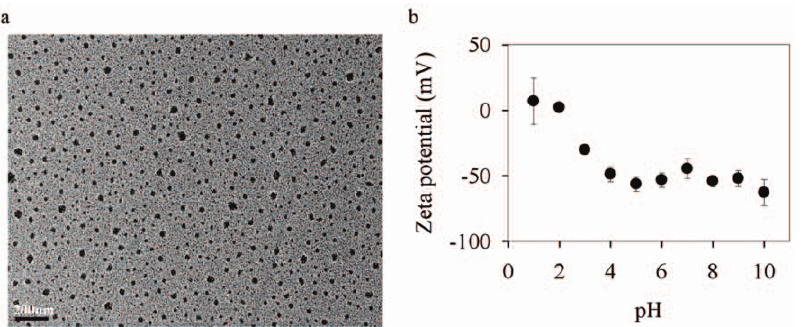
Figure 1. The transmission electron microscope image of TiO 2 -ENs dispersed in the modified WC medium (WC m ) (a) and their zeta potentials (mV) at different pH (b).